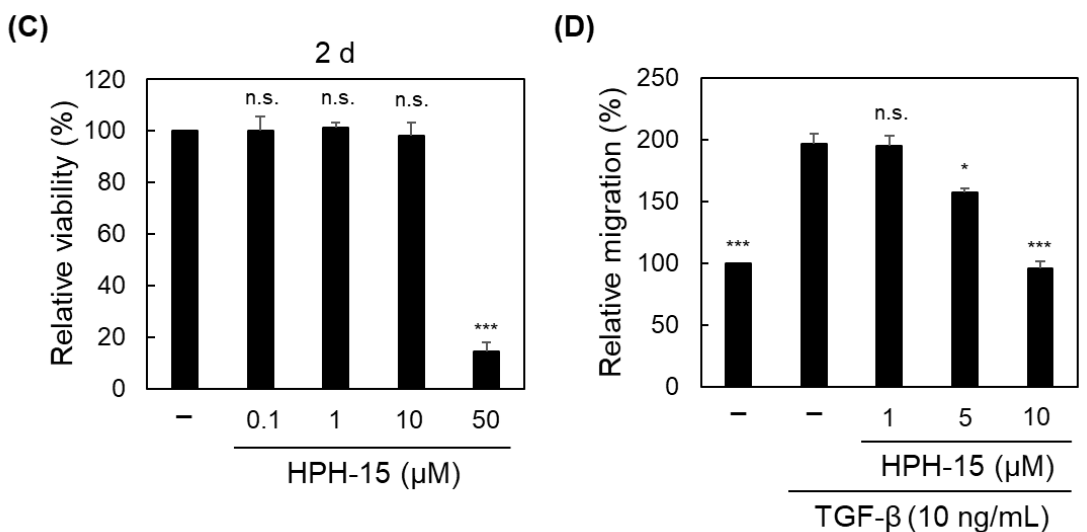
Figure 1. Anti-cell migration activity of HPH-15. ( A ) Structure of HPH-15. ( B ) and ( C ) Viability of A549 cells treated with HPH-15. After incubation of the cells for 1 ( B ) or 2 d ( C ) in the presence of various amounts of HPH-15, MTT assays were performed. Relative values are shown. ( D ) Migration of TGF- β -stimulated A549 cells treated with HPH-15. In vitro scratch assays of the cells, incubated in the presence of various amounts of HPH-15 and TGF- β (10 ng/mL) for 1 d, were performed. Relative values are shown. * p < 0.05, *** p < 0.001; n.s.—not significant compared with samples without HPH-15 as in ( B ) and ( C ), and without HPH-15 but with TGF- β as in ( D).